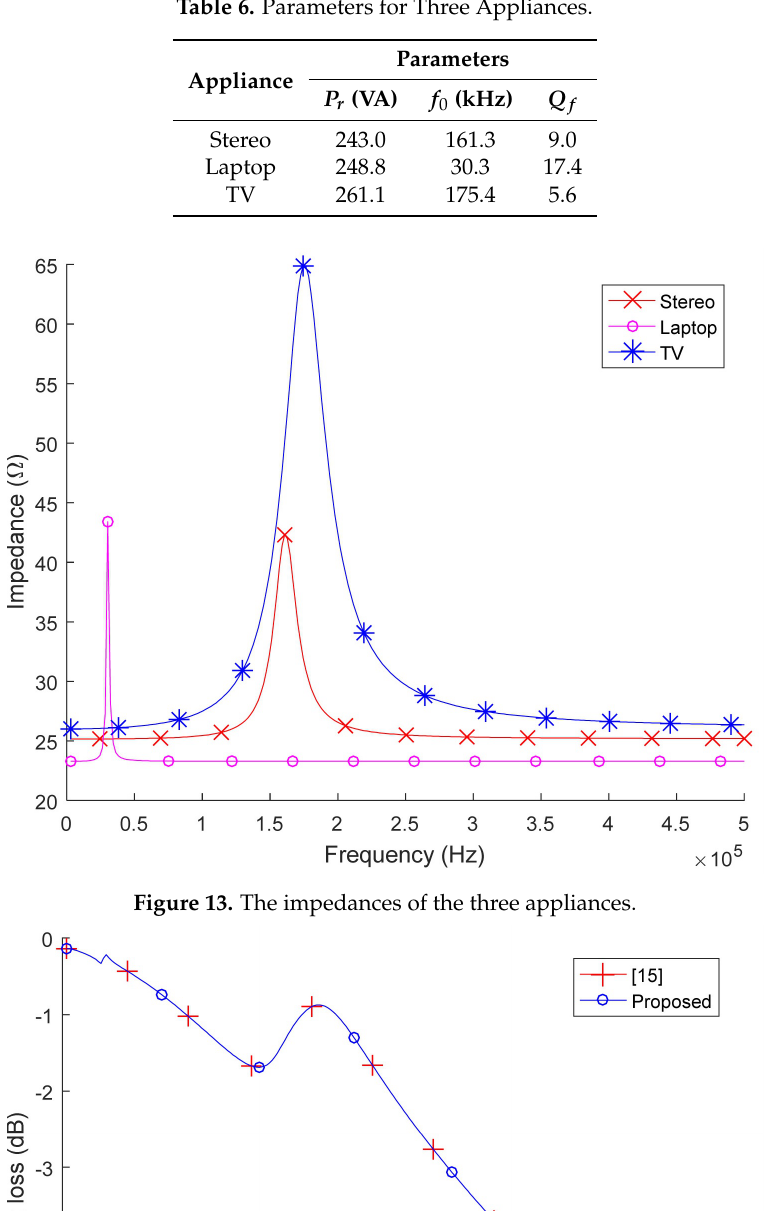
Figure 13. The impedances of the three appliances.